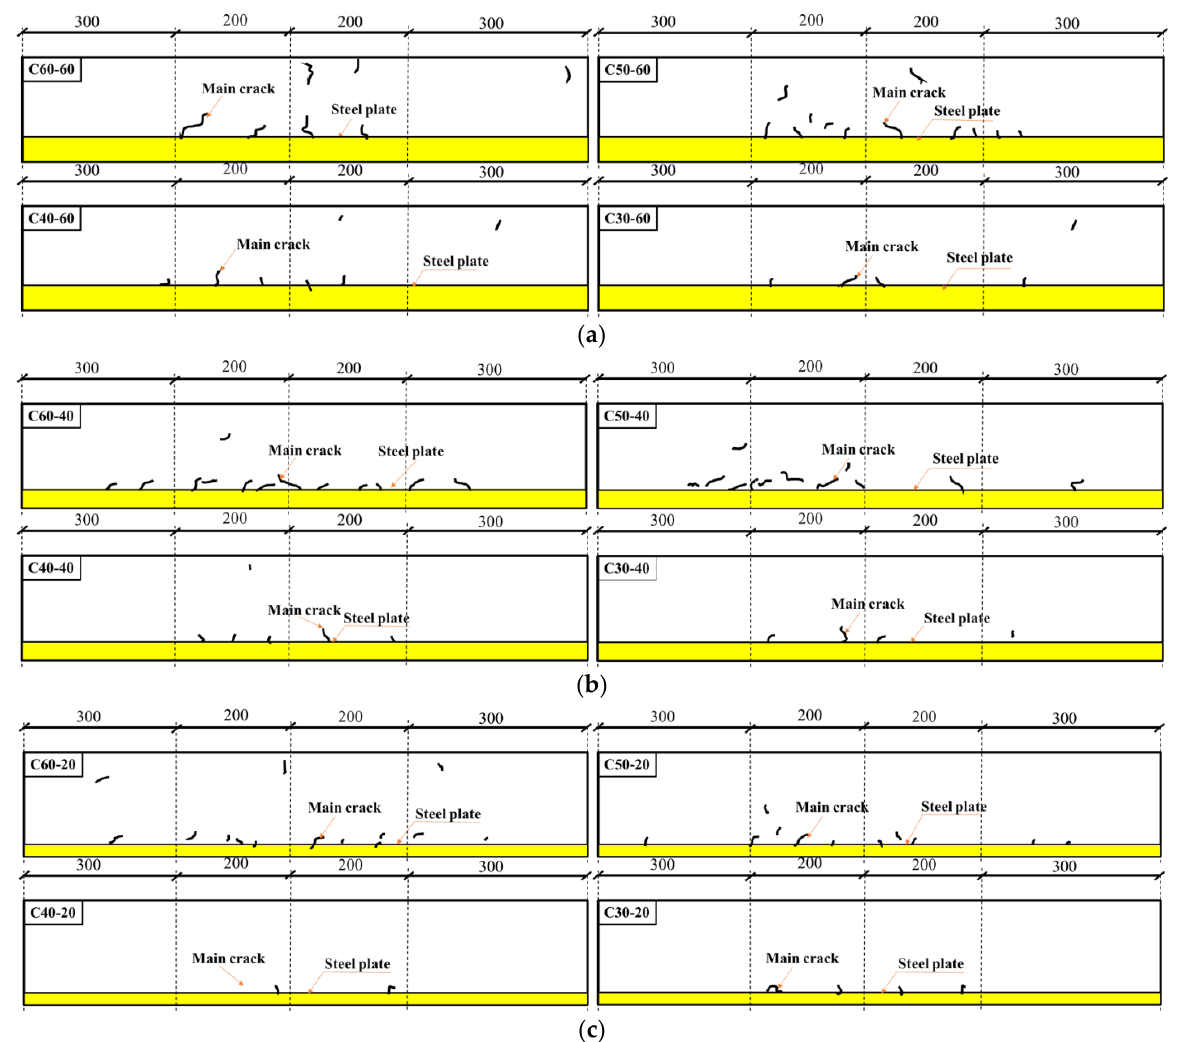
Figure 9. Cracking schematic diagram: ( a ) Steel plate thickness is 60 mm; ( b ) steel plate thickness is 40 mm; ( c ) steel plate thickness is 20 m. Table 9. Cracking observation.